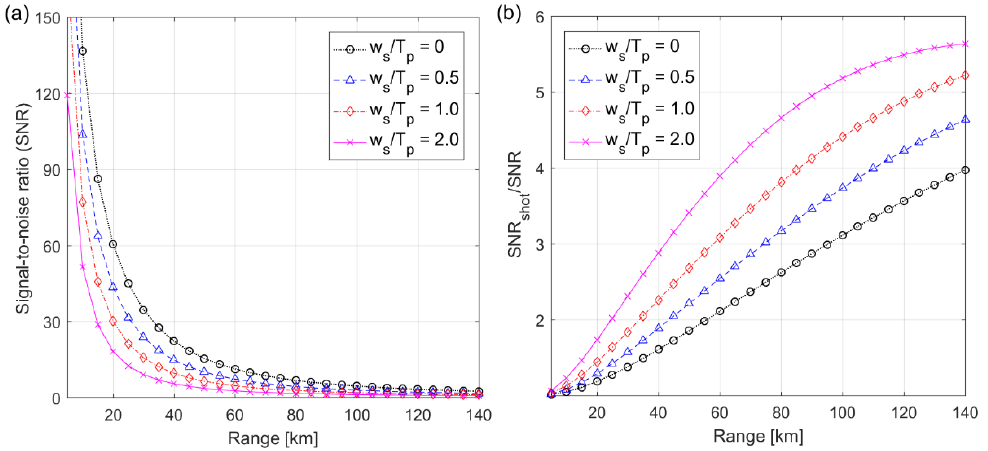
Figure 9. Signal-to-noise ratio ( a ) and ratio of signal-to-noise ratio of the signal shot-noise limited detection to the noise detection ( b ) for the fixed pulse width of T p = 8 ns. SNR shot is the signal-to-noise ratio corresponding to the signal shot-noise limited detection to neglect background noise and detector noise.